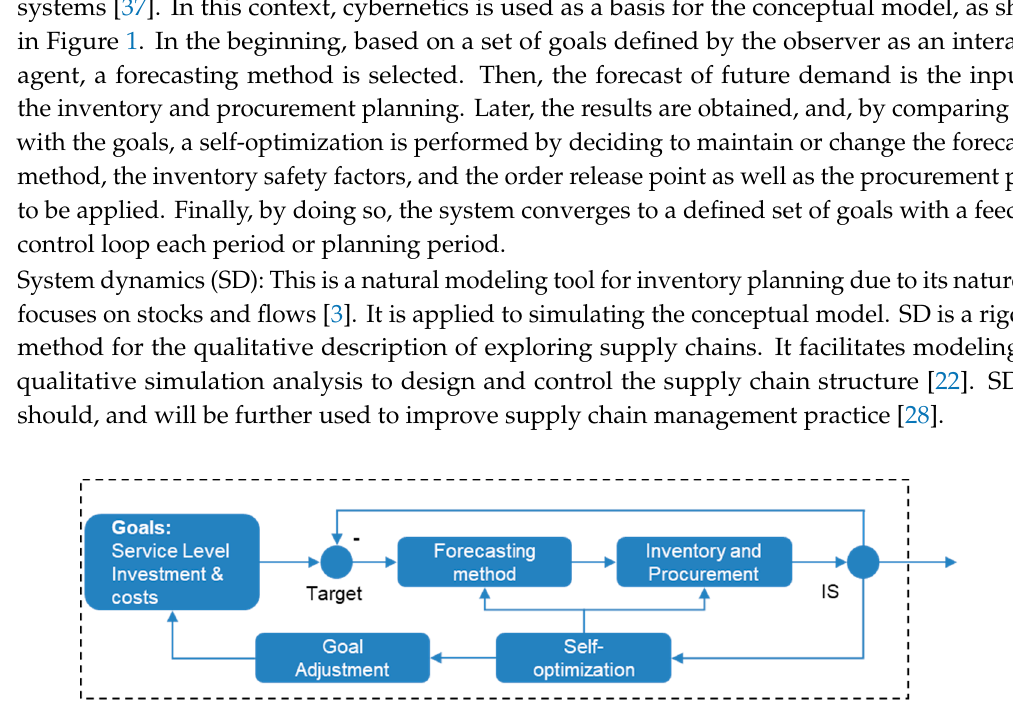
Figure 1. Cybernetics model for a market-oriented procurement (own elaboration based on [38] (p. 751)).